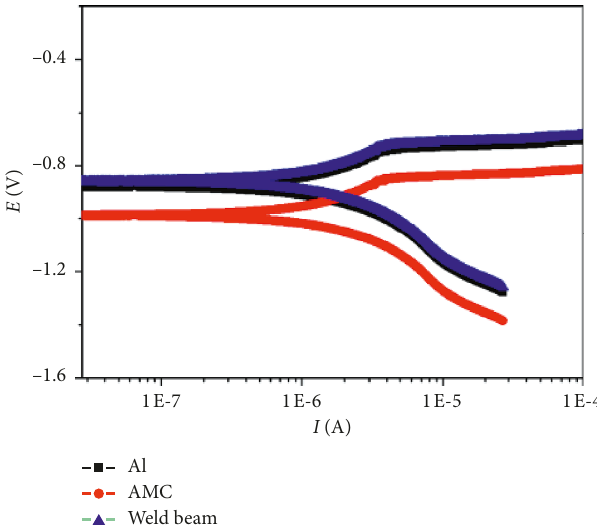
Figure 6: The potentiodynamic polarization curves for different samples in 5% NaCl solution.